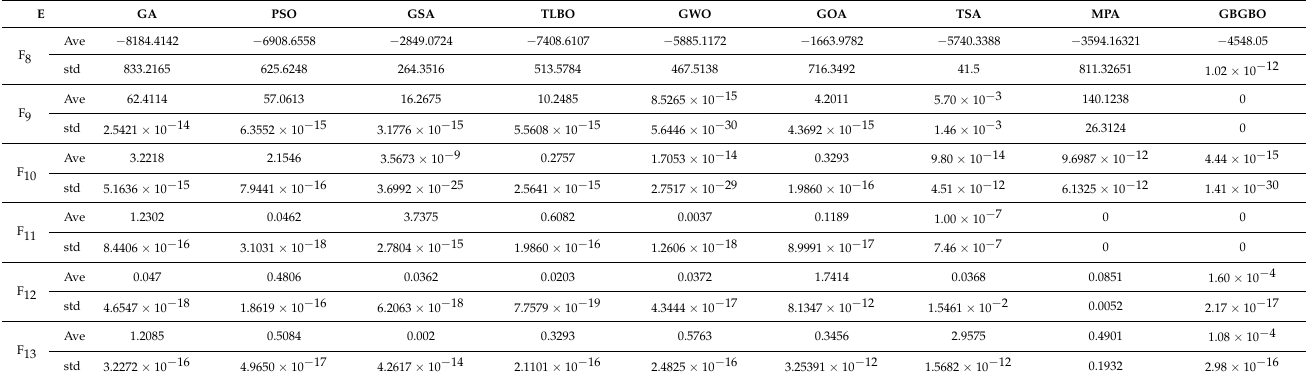
Table 3. Optimization results of GBGBO and other algorithms on high dimensional test